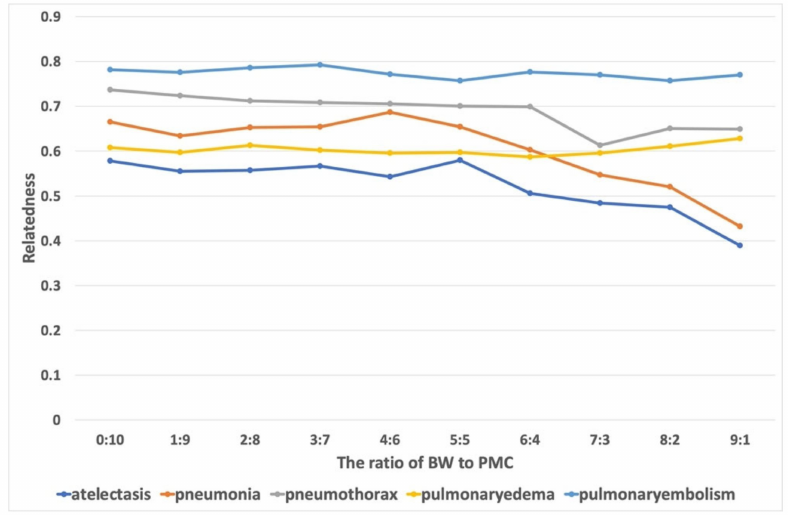
Figure 2. Similarity of five pairs in